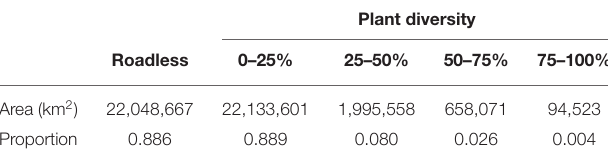
TABLE 1 | Total area (km 2 ) and proportion of deserts that fall into the two methods of assessing conservation value: roadless areas and vascular plant diversity